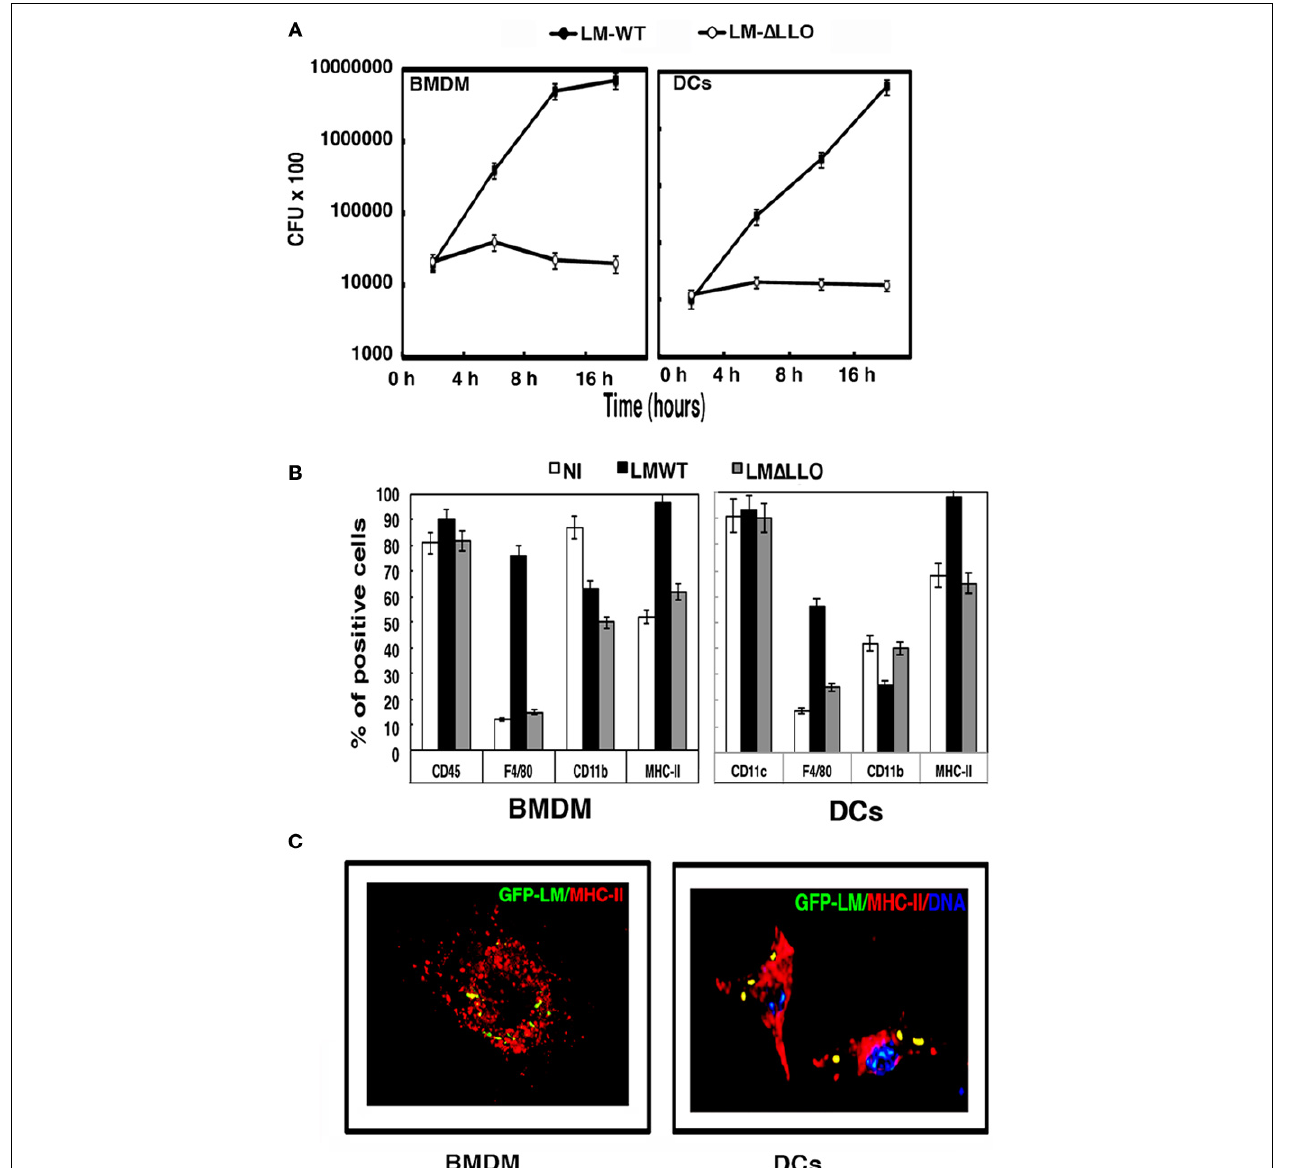
positive cells for each antibody are shown. Results are expressed as the mean ± SD of triplicate samples ( P < 0 . 05). (C) Images correspond to confocal microscopy projections of BMDMs or DCs infected with GFP-LM (green channel), anti-MHC-II antibodies that label the antigen-processing compartments (Y3P biotinylated antibody followed by goat anti-mouse TRITC labeled) (red channel) and DNA (blue channel). Colocalization of GFP-LM and MHC-II (yellow fluorescence) is observed in BMDMs and DCs images. All BMDM preparations were CD11b + CD45 + F4/80 high MHC-II high , reflecting their macrophage origin and purity and DC preparations were CD11c + F4/80 high CD11b low MHC-II high , reflecting their DC origin and